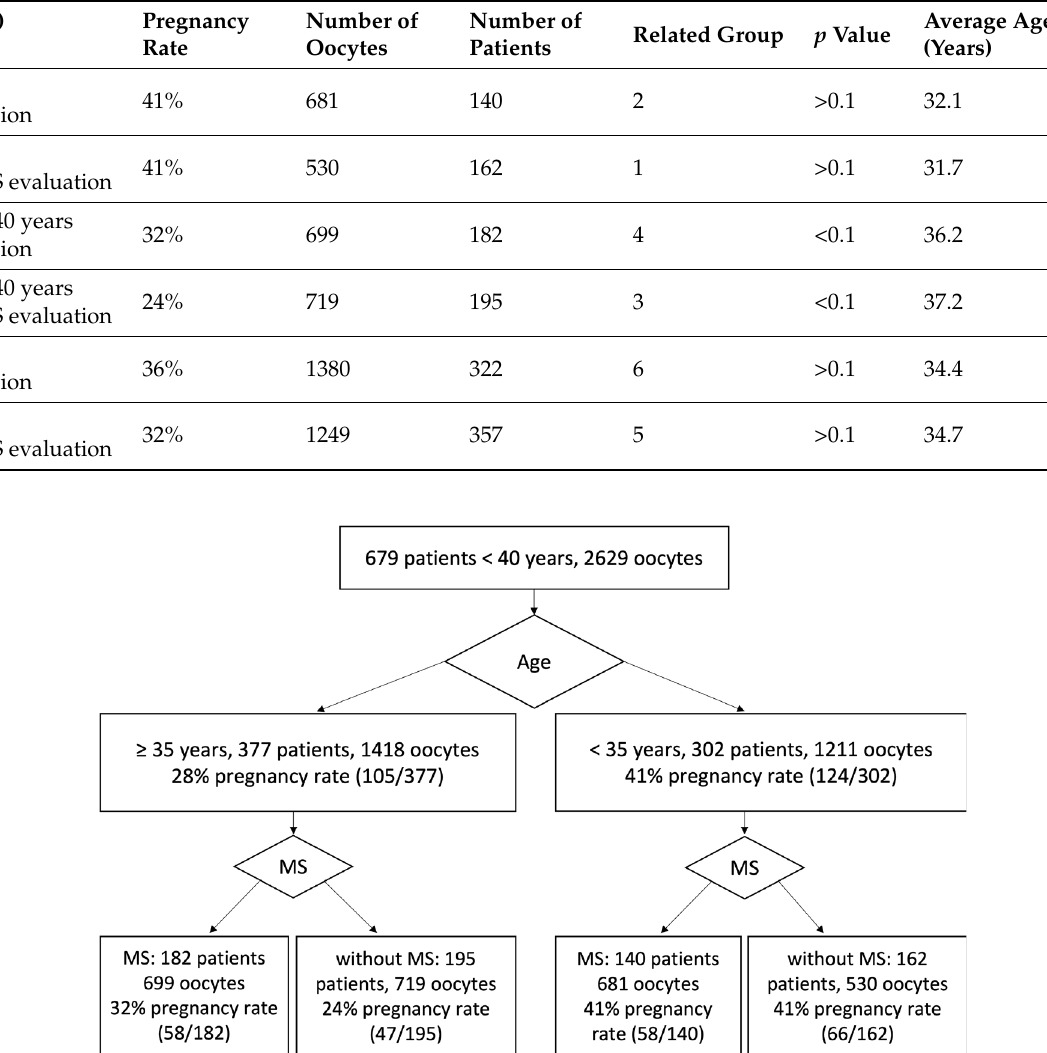
Table 1. Number of patients, their average ages, number of oocytes in group, average number of oocytes per OPU, and pregnancy rates calculated for groups of patients of different age and different treatment: treated either with MS evaluation or without MS evaluation. The significance values of the difference between pregnancy and utilization rates were calculated.